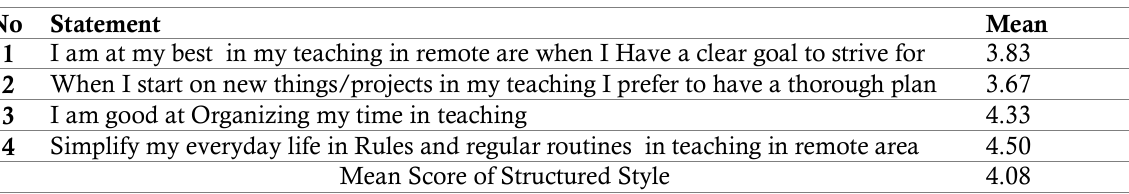
Table 3 . Structured